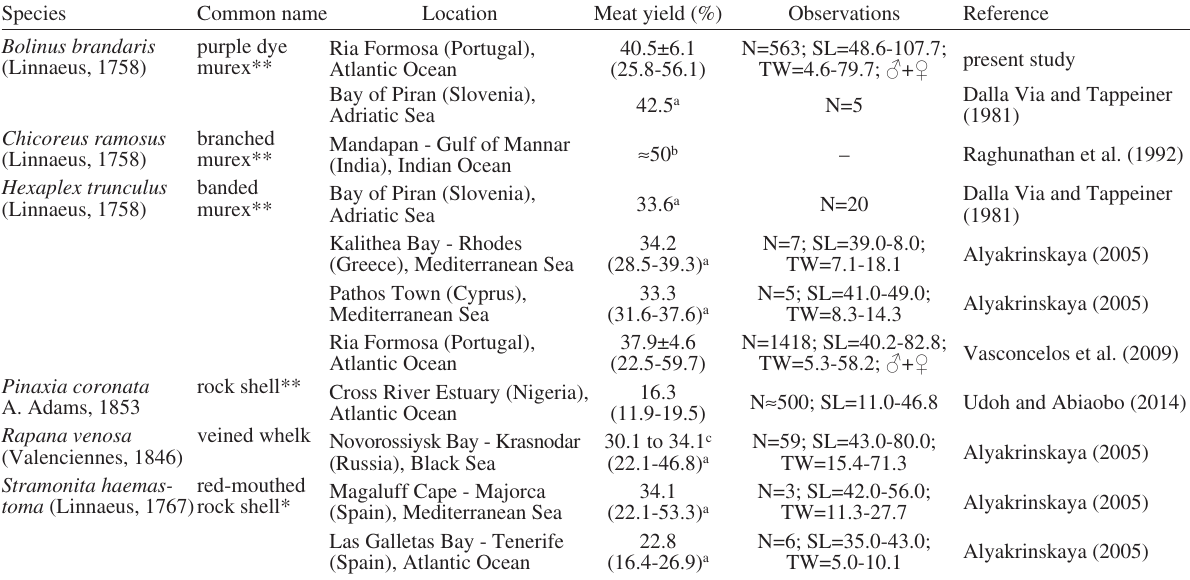
Table 2. – Comparison of the meat yield of Bolinus brandaris from the Ria Formosa lagoon and other species within the family Muricidae, including some edible and/or commercially valuable muricids. Notes: Meat yield data presented as mean±SD and range (minimum – maxi- mum); *, edible species; **, commercially valuable species; a , data converted from percentage shell weight to total weight; b , data expressed as percentage of soft-body total weight; c , variable depending on collecting site and date; N, number of individuals; SL, shell length range (mm); TW, total weight range (g); ♂ + ♀ , sexes